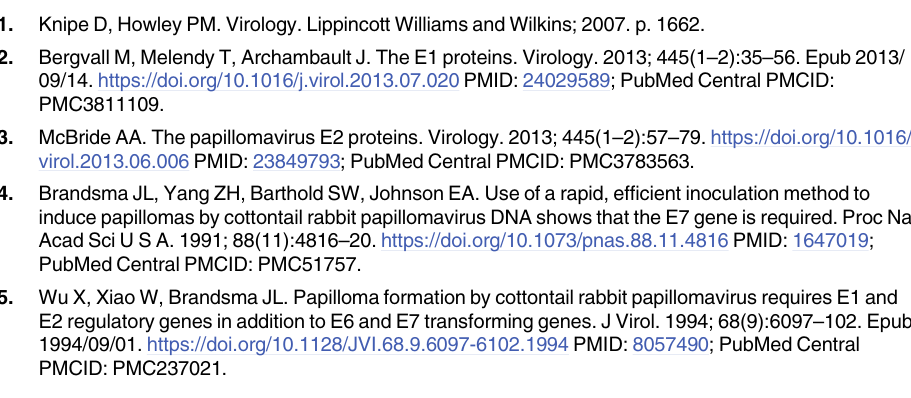
S6 Fig. E6-expressing EGFP-labeled -keratinocytes extend basally beneath normal-red- tagged keratinocytes, forcing the normal keratinocytes off the attachment substrate. HPV16 E6 expressing keratinocytes tagged in green were seeded at 0.1% and vector trans- duced keratinocytes tagged in red were seeded at 99.9% and cultured for 21 days as described in Fig 1. Confocal Images were captured with a 10X objective; the bar at lower left indicates 50 um. Blue color is DAPI stained DNA signal. The three-color image with white boxes indicates the location of z-plane image construction; adjacent z-plane images show that 16E6 green cells are basal to vector-red